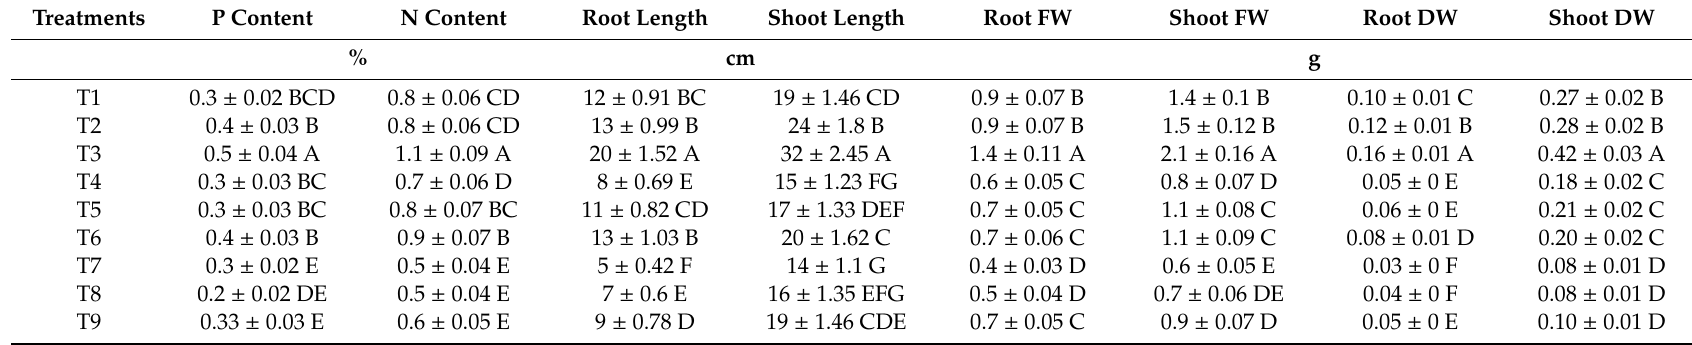
Table 1. Leaf phosphorus (P) and nitrogen (N) contents and Root and Shoot biomass / growth of un-amended and amended soybean plants with chitosan modified and as-is biochar under saline